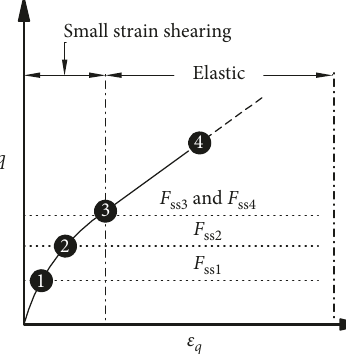
Figure 3: Schematic of small strain loading. F strain yield surface position at point i , where i � 1, 2, 3, and 4.